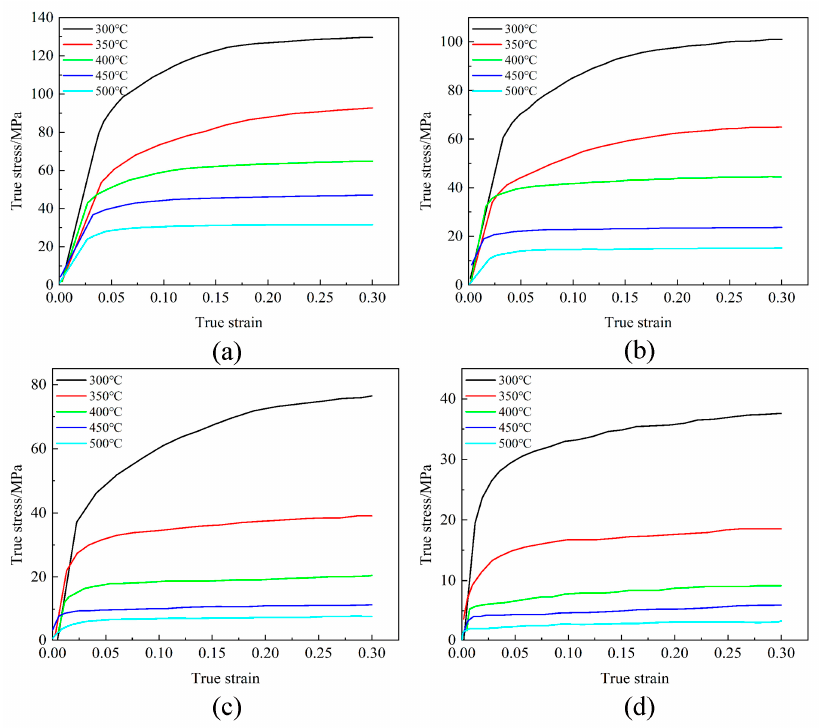
Figure 2. True stress–strain curves of specimens under different deformation temperatures with . . . . ε = 1 × 10 − 1 s − 1 ; ( b ) ε = 1 × 10 − 2 s − 1 ; ( c ) ε = 1 × 10 − 3 s − 1 ; ( d ) ε = 1 × 10 − 4 s − 1 . strain rates of: ( a ) strain rates of: ( a ) ε (cid:4662) = 1 × 10 − 1 s − 1 ; ( b ) ε (cid:4662) = 1 × 10 − 2 s − 1 ; ( c ) ε (cid:4662) = 1 × 10 − 3 s − 1 ; ( d ) ε (cid:4662) = 1 × 10 − 4 s − 1 .